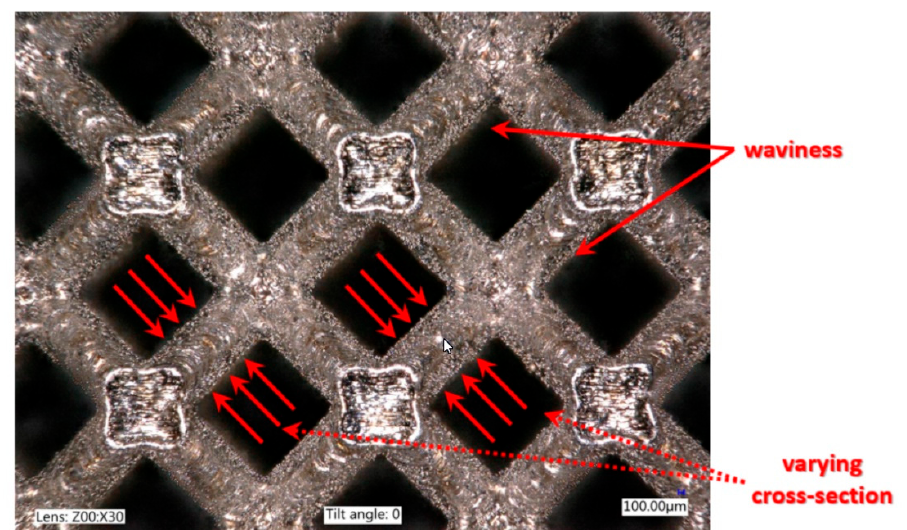
Figure 5. Strut-level defects generated during the SLM process.